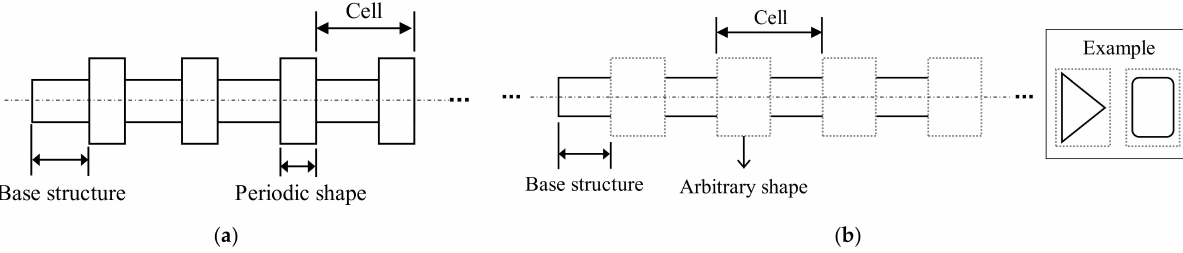
Figure 2. The general concept of periodic structures. ( a ) Generally known periodic structure and ( b ) Use various shapes as a periodic